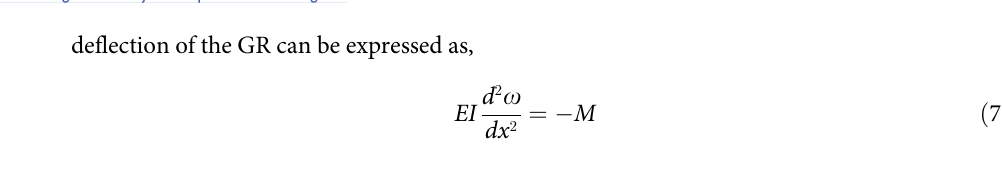
Fig 3. Analysis of the internal force of a soil element between piles for a GRPSE system with multi-layers of GR.